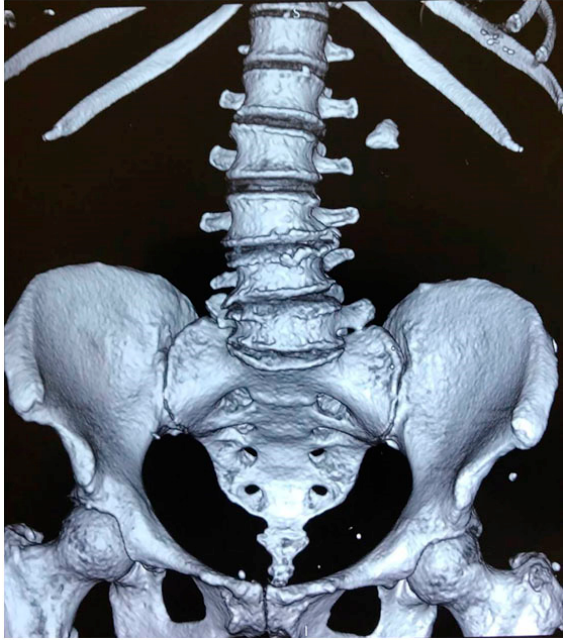
Figure 5. CT scan. The stone is in the projection of the left kidney, 1.9 × 1.7 cm, density 1380 HU.